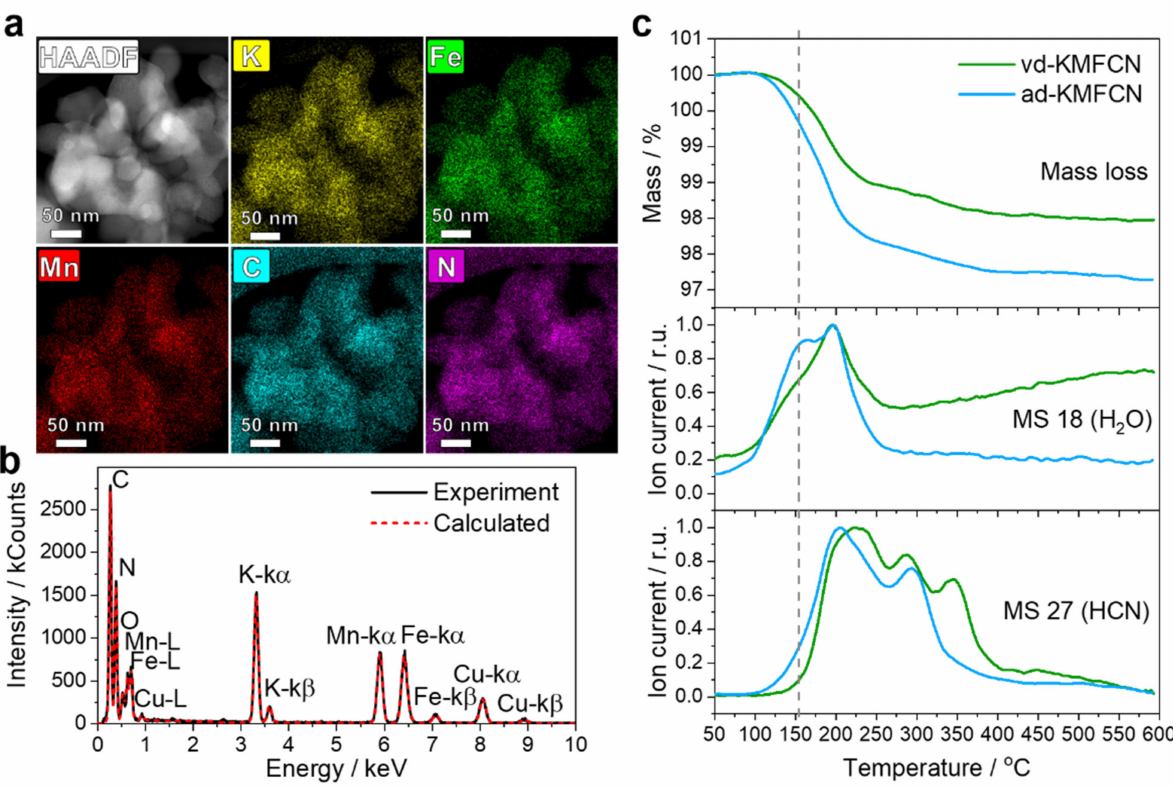
Figure 1. ( a ) HAADF STEM image and STEM-EDX mapping of ad-KMFCN. Yellow—K, green—Fe, red—Mn, light-blue—C, magenta—N. Approximate size of the crystallites was 50–70 nm. ( b ) Typical EDX spectrum of ad-KMFCN nanoparticles. ( c ) TGA-MS curves of ad- and